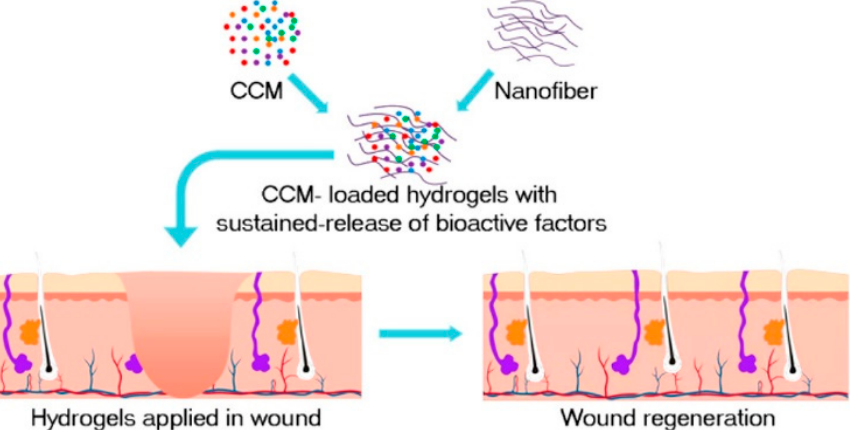
Figure 1. The preparation process of CMM-silk nanofiber composite hydrogel. The injectable hydrogel is used as a vehicle to load bioactive molecules secreted by the CMM, such as transforming growth factor- β 1 (TGF- β 1), insulin-like growth factor binding protein-1 (IGFBP-1), and platelet-derived growth factor-AB (PDGF-AB). Reprinted with permission from [46]. Copyright (2019) American Chemical Society.